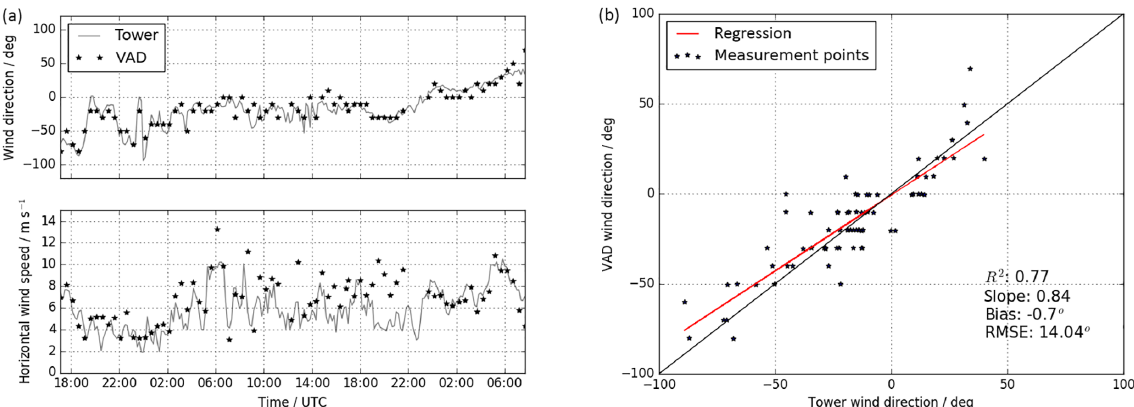
Figure 6. Comparison of lidar #3 VAD scans with sonic anemometer measurements at 80m on tower 20/tse04 from 17 to 19 May. (a) Com- parison of the time series of wind direction and wind speed, and (b) a regression plot of wind directions.